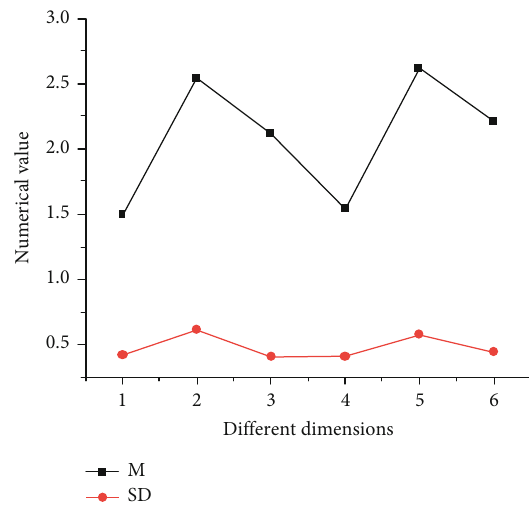
Figure 7: Statistics of the basic situation of college students ’ parenting styles (1: father ’ s rejection 2: father ’ s emotional warmth; 3: father ’ s overprotection; 4: mother ’ s rejection; 5: mother ’ s emotional warmth; 6: mother ’ s overprotection).